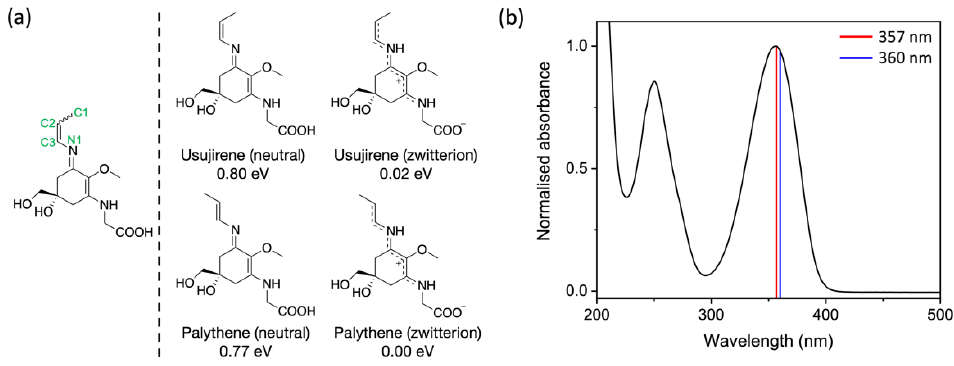
Figure 1. ( a ) Left: Structure of usujirene and palythene with relevant atom numbers labelled. Right: Chemical structures of usujirene and palythene both displayed as their neutral and zwitterionic conformers. Their relative energies calculated at the density functional theory (DFT)/PBE0/6-311++G** level in implicitly modelled water are reported with respect to zwitterionic palythene, the lowest energy conformer. ( b ) UV-visible spectrum of the usujirene/palythene aqueous solution with their respective peak absorptions given as vertical lines; red for usujirene and blue for palythene [4].